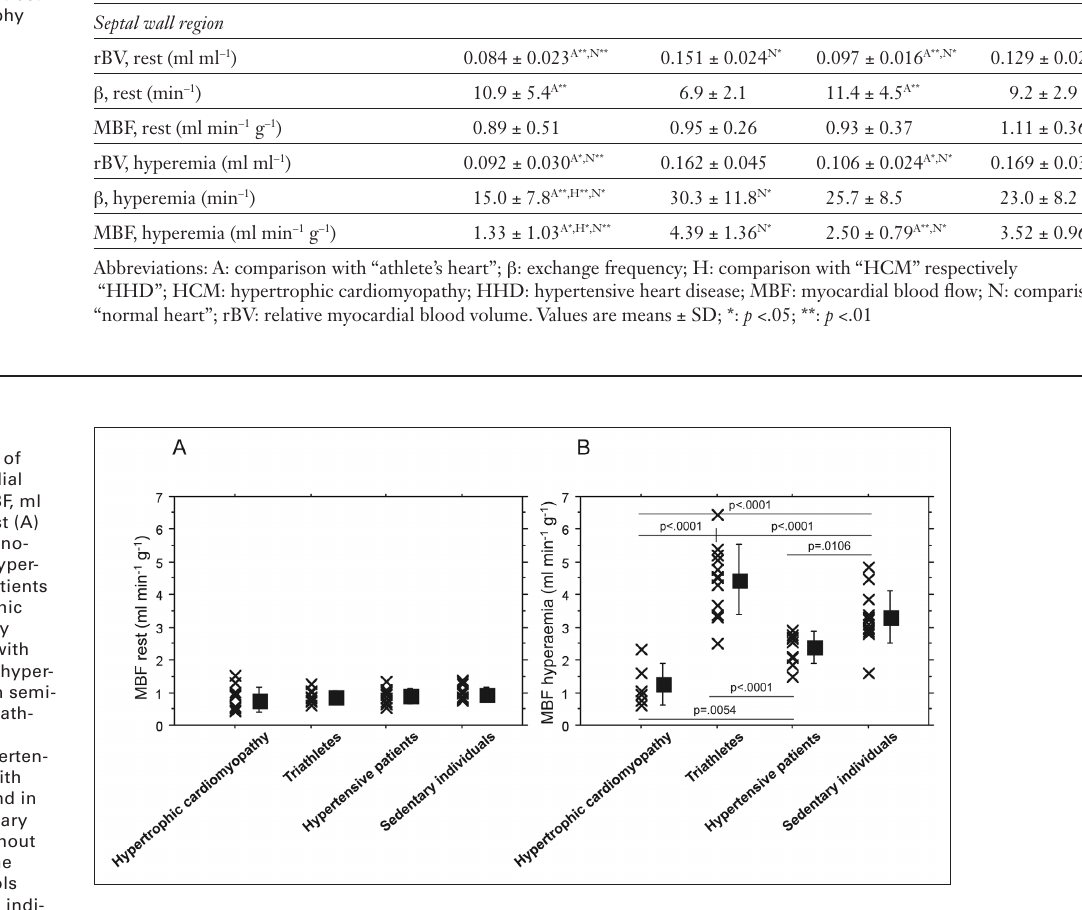
Myocardial contrast echocardiography data.